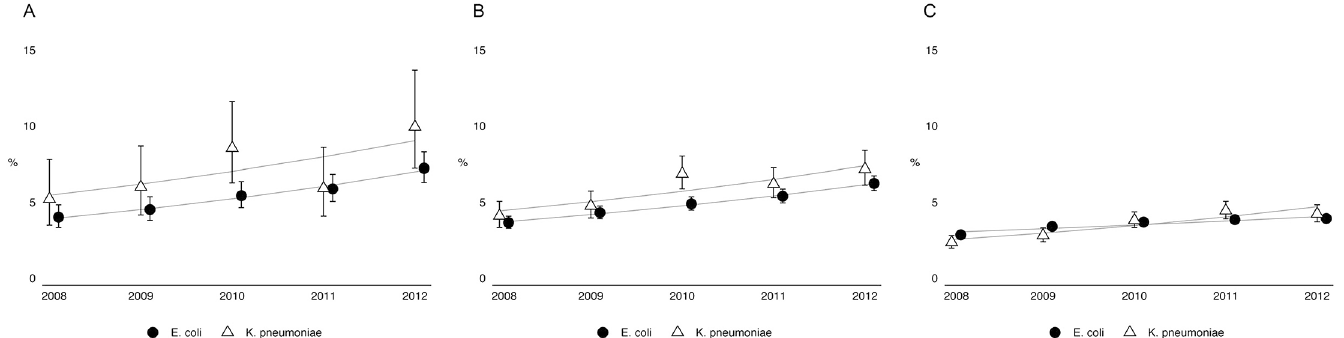
Fig 2. The proportion (in %) of extended-spectrum cephalosporin-resistant Escherichia coli and Klebsiella pneumoniae isolates, for blood isolates (A), male urine isolates (B) and female urine isolates (C) from 2008 – 2012, ISIS-AR, the Netherlands. The point-estimates and log-linear trends per year were estimated with a generalized estimation equation (GEE) for log-binominal regression including time in years, and patient characteristics, including age, gender, patient setting and geographic region. The error bars represent the 95% confident intervals of each of the